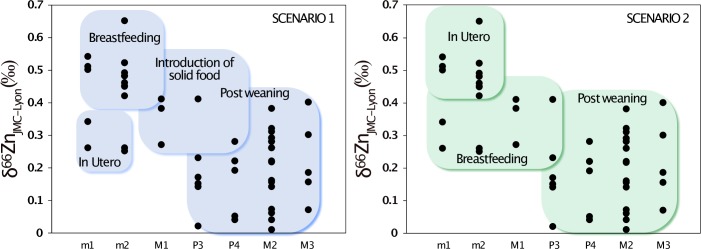
Possible scenarios for the evolution of enamel δ66Zn values in teeth during childhood.